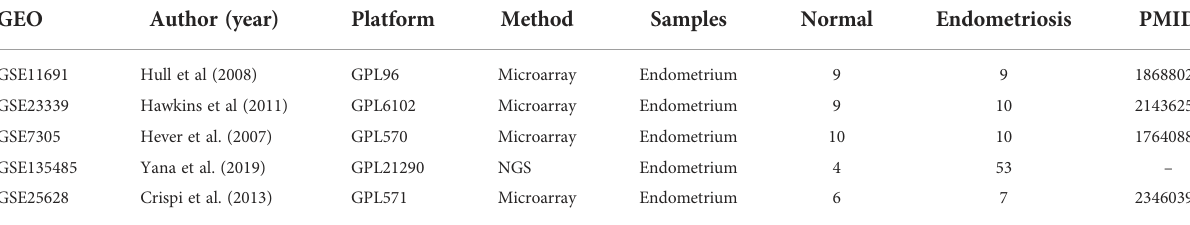
TABLE 1 Details of endometriosis GEO data used in this